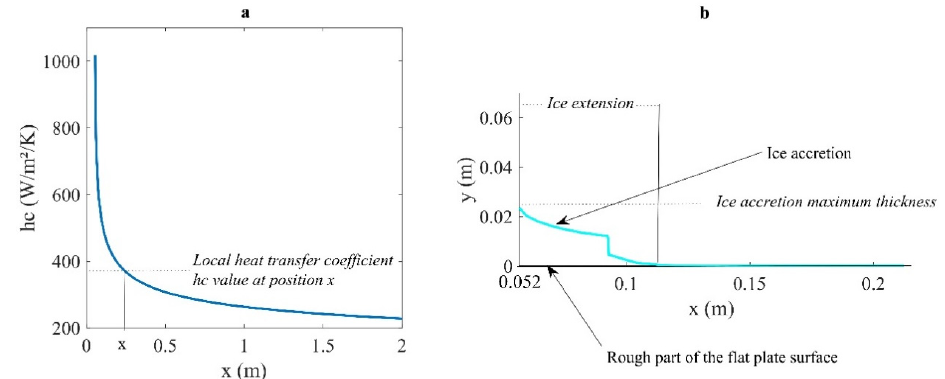
Figure 6. Outputs of interest for ( a ) the heat transfer coefficient and ( b ) the ice accretion.